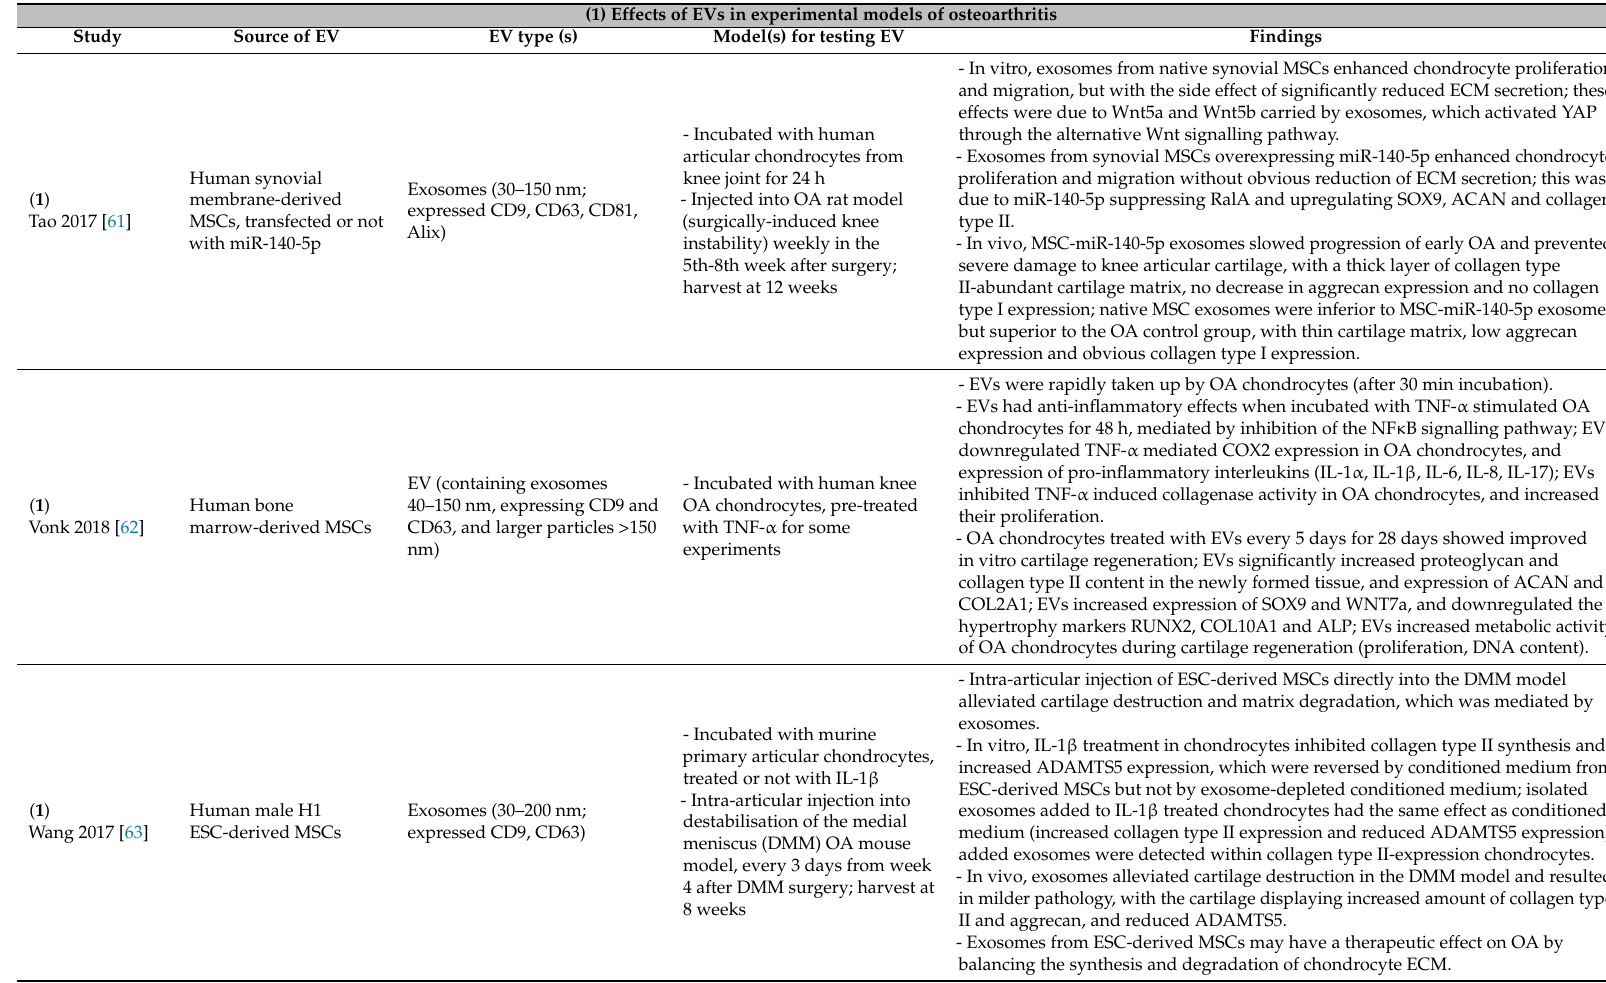
(1) Effects of EVs in experimental models of osteoarthritis